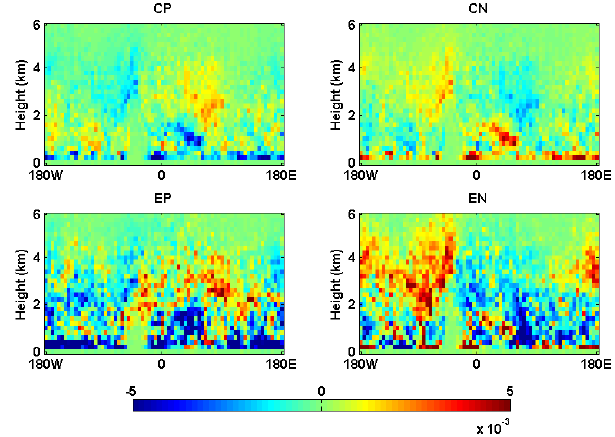
Fig. 6. Same as Fig. 5, but for only for ice phase clouds derived Fig. 6: Same as Fig. 5, but for only for ice phase clouds derived using CALIPSO data. using CALIPSO data.